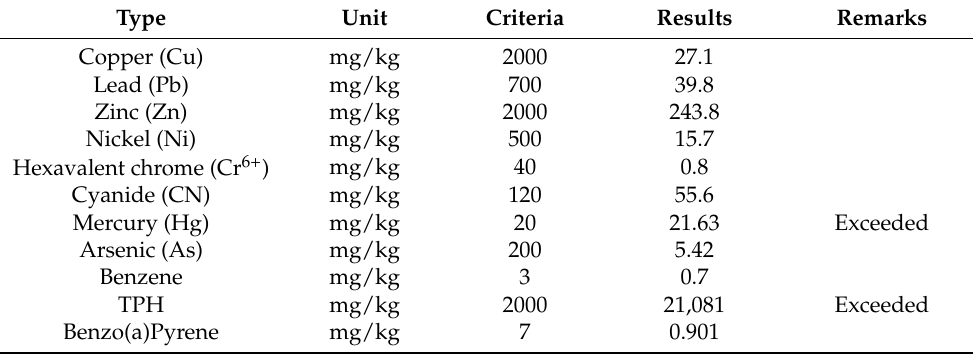
Table 2. Contaminants in multi-contaminated soil sample.